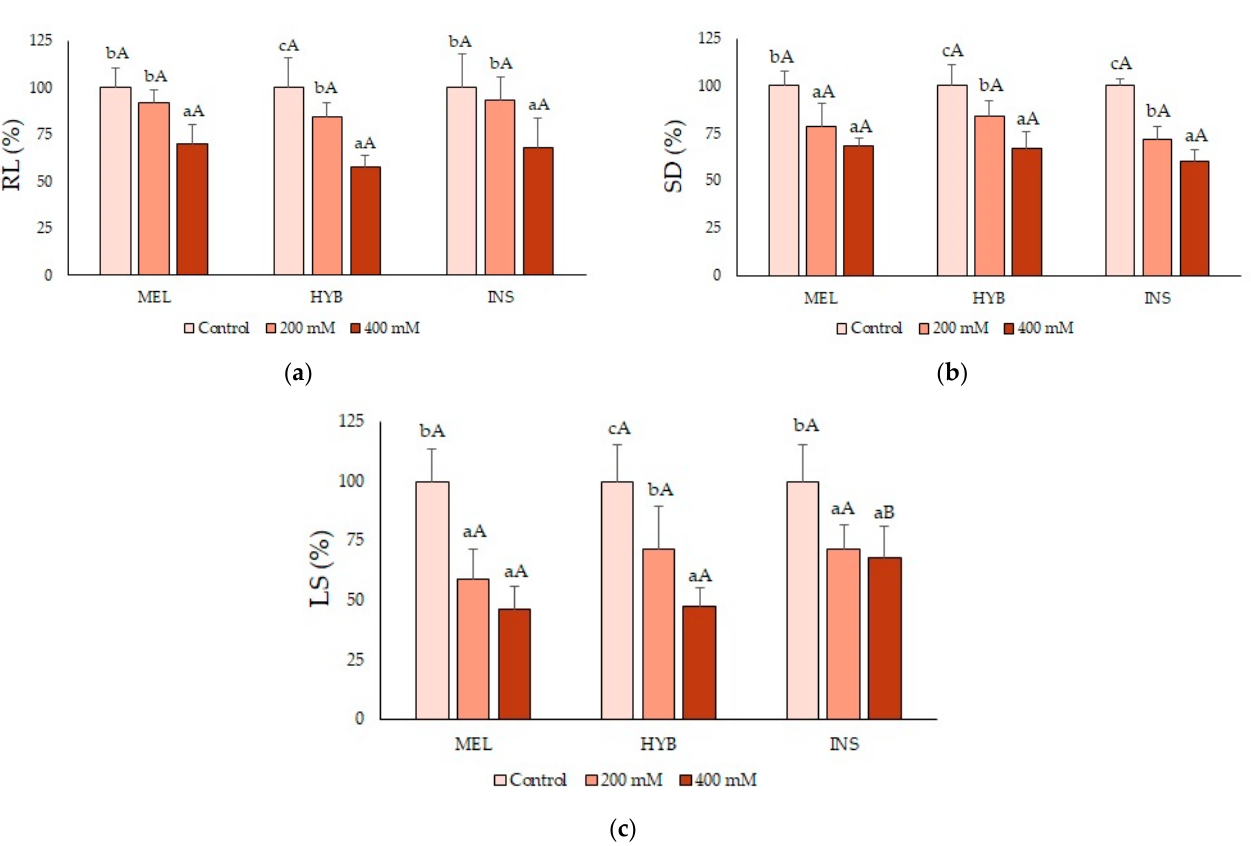
Figure 3. Root length (RL) ( a ), stem diameter (SD) ( b ) and leaf surface (LS) ( c ) in Solanum melongena (MEL), Solanum insanum (INS) and their hybrid (HYB) in the conditions tested (control, 200 mM and 400 mM of NaCl, as indicated). Percentages (mean ± SD; n = 5) refer to the corresponding control as 100%, with absolute values for RL (cm): [MEL = 30.4, HYB = 31.7, INS = 26.9], SD (mm): [MEL = 4.7, HYB = 5.2, INS = 5.3] and LS (cm 2 ): [MEL = 187.6, HYB = 207.9, INS = 121.3]. Different lowercase letters within the same genotype indicate statistically significant differences between treatments, and different uppercase letters within the same treatment indicate statistically significant differences between genotypes ( p < 0.05), according to the Student–Newman–Keuls multiple range test. Table 2. Root (RWC) ( a ), stem (SWC) ( b ) and leaf (LWC) ( c ) water content (%) (mean ± SD; n = 5) in Solanum melongena (MEL), Solanum insanum (INS) and their hybrid (HYB) in the conditions tested (control 200 mM and 400 mM of NaCl, as indicated). Different lowercase letters within the same genotype indicate statistically significant differences between treatments, and different uppercase letters within the same treatment indicate statistically significant differences between genotypes ( p < 0.05), according to the Student–Newman–Keuls multiple range